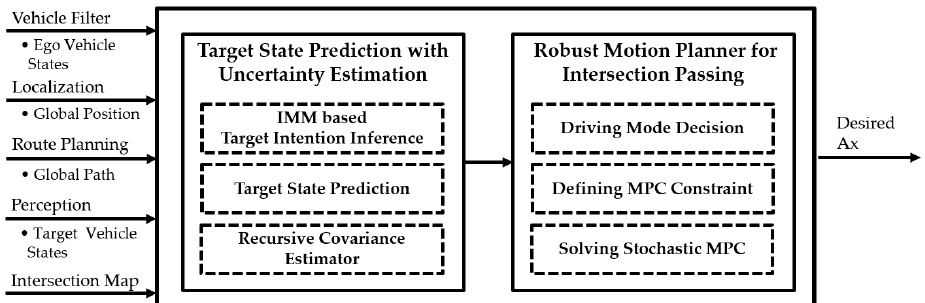
Figure 2. Architecture of the proposed motion-planning algorithm for an uncontrolled intersection.